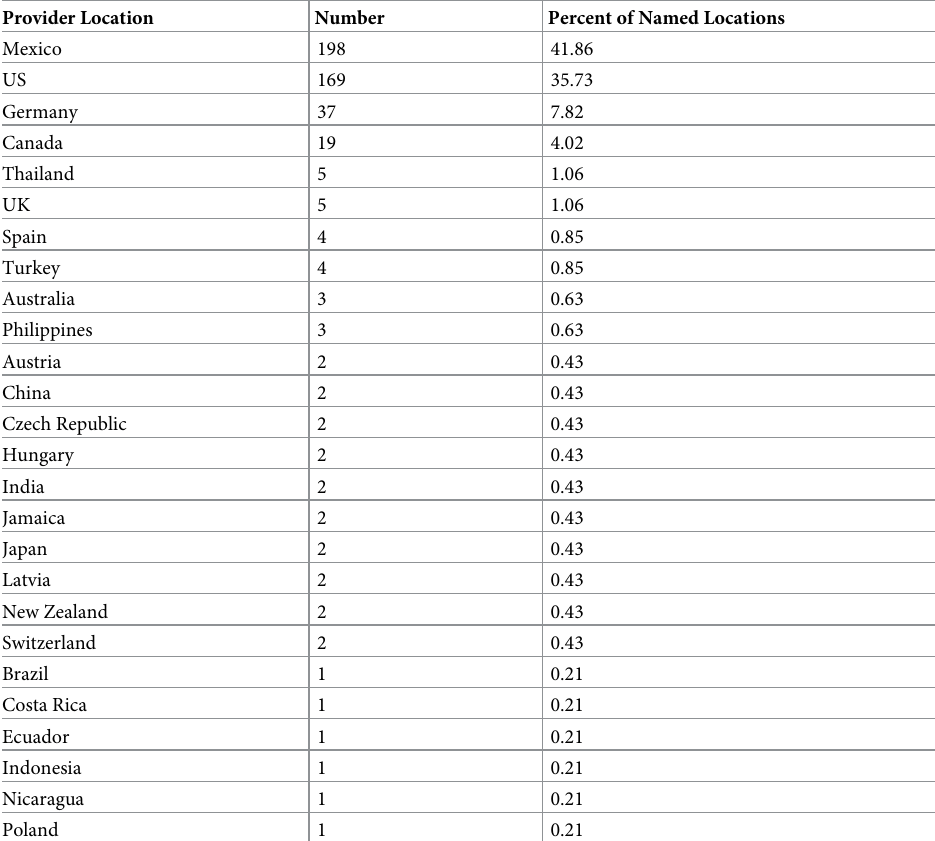
Table 6. CAM provider